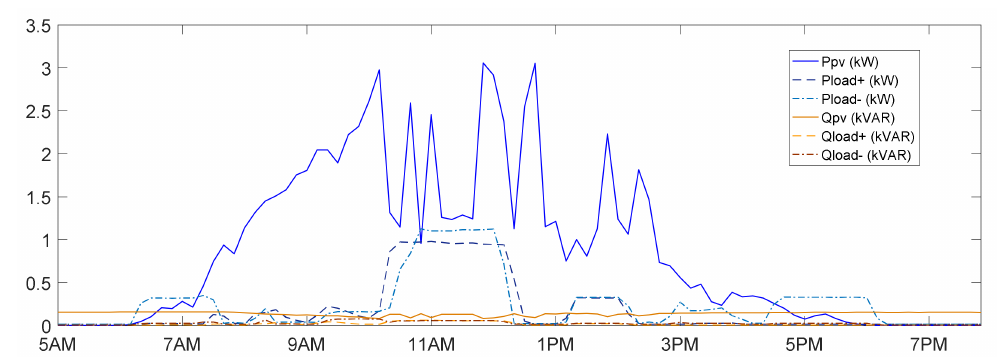
Figure 6. Power behaviour of Phase B.